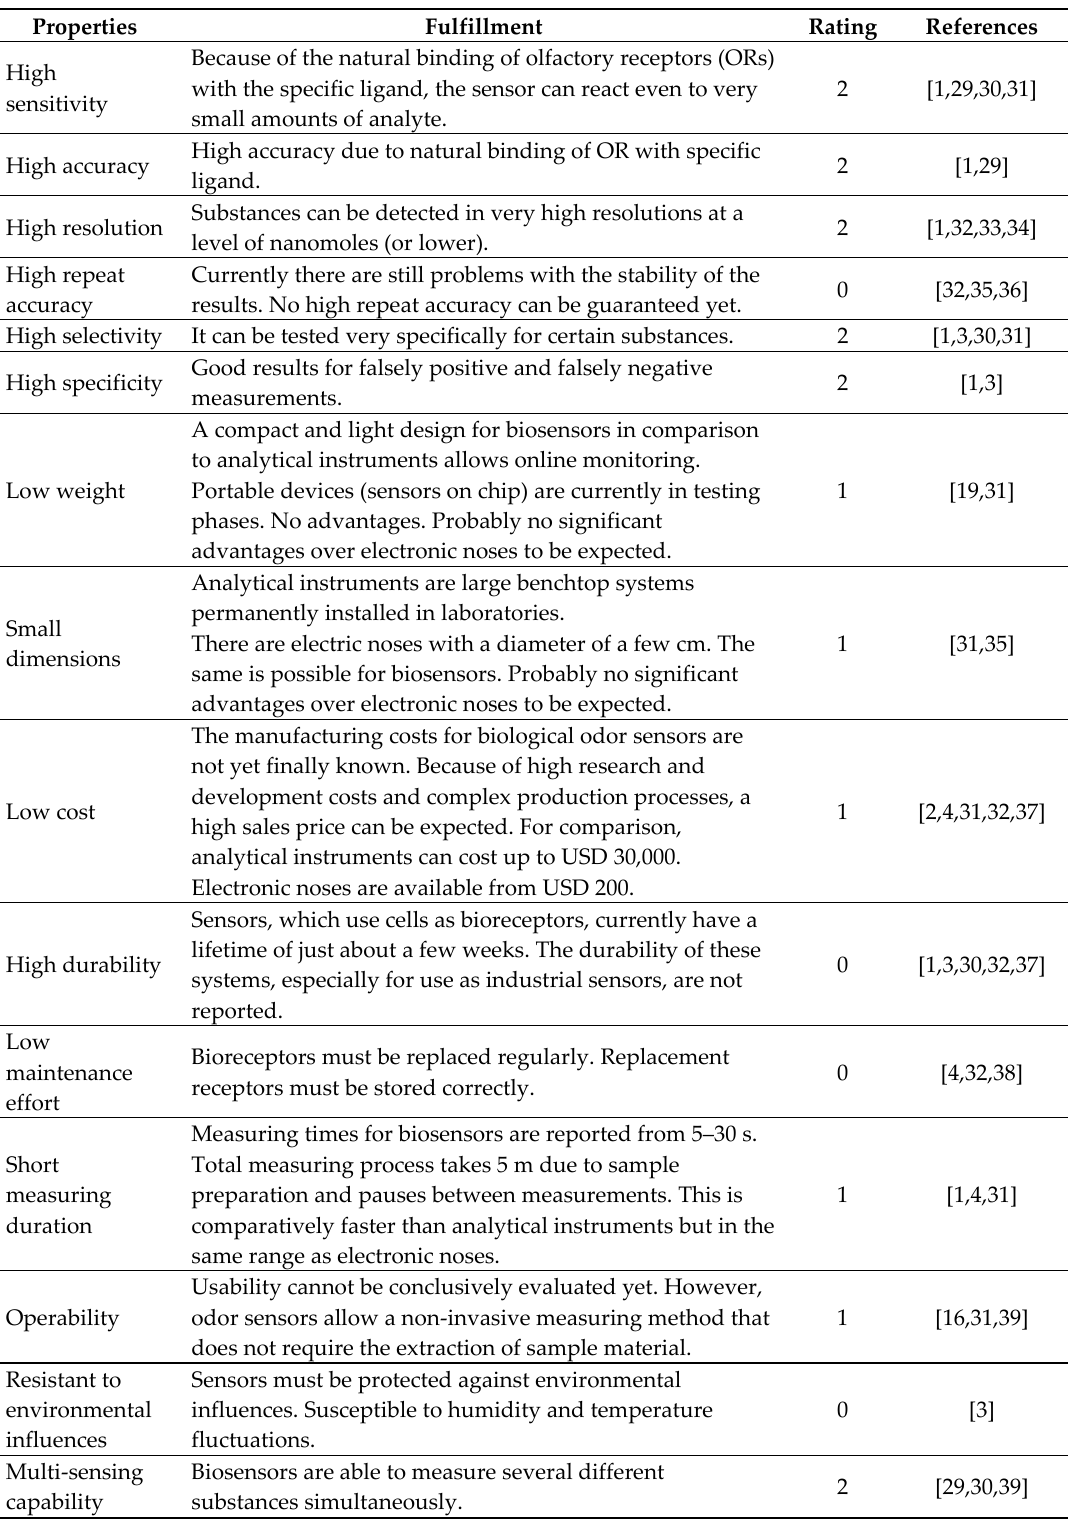
Table 1. Evaluation of the fulfillments of performance criteria by bioelectric odor sensors; fields: 0 = is fulfilled worse by comparison; 1 = is fulfilled equally well or no clear statement to be made; 2 = is fulfilled comparatively